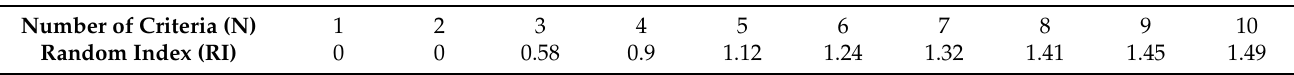
Table 3. Random index (RI)